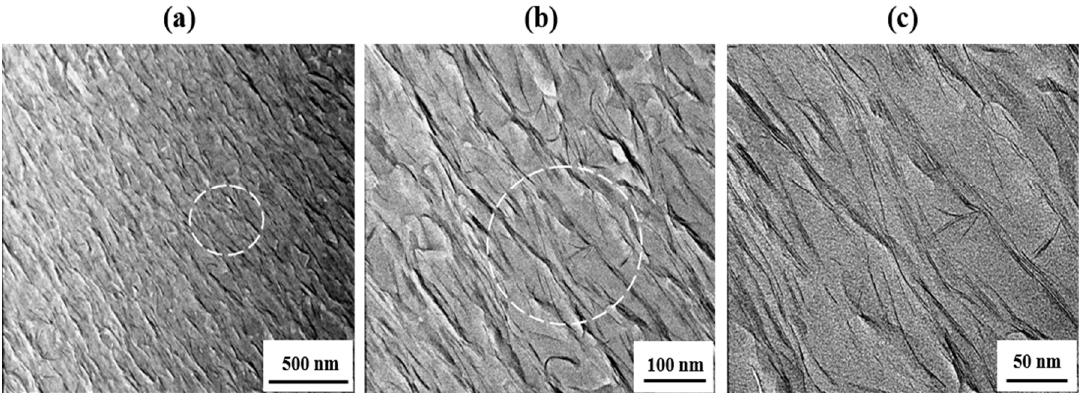
Figure 7. TEM images of the Co-PI hybrid film containing 40 wt % STN at different magnifications.